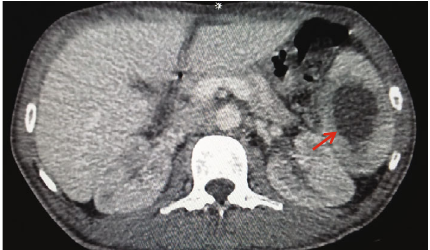
Figure 3: CECT abdomen; irregular hypodense ring-enhancing lesion in the parenchyma of the spleen